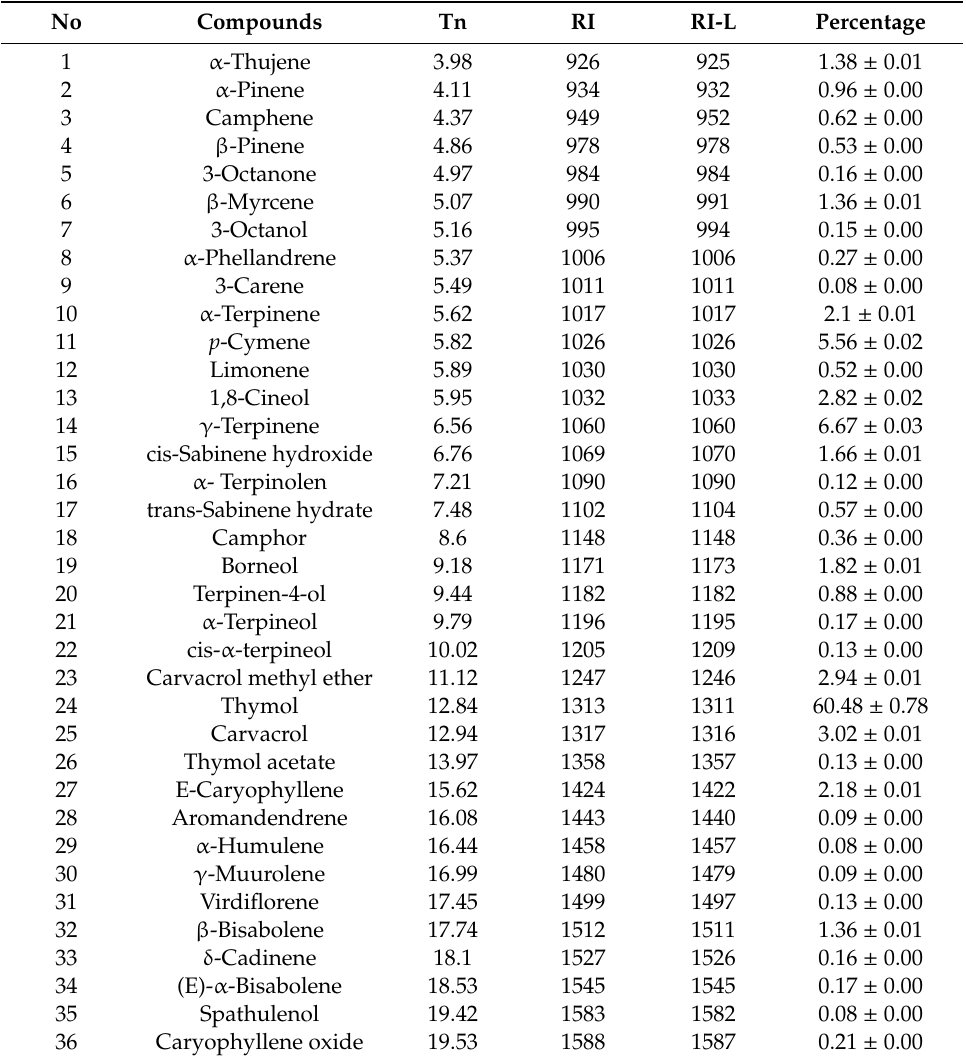
Table 1. Percentage chemical composition and retention indices of the essential oil of Thymus kotschyanus